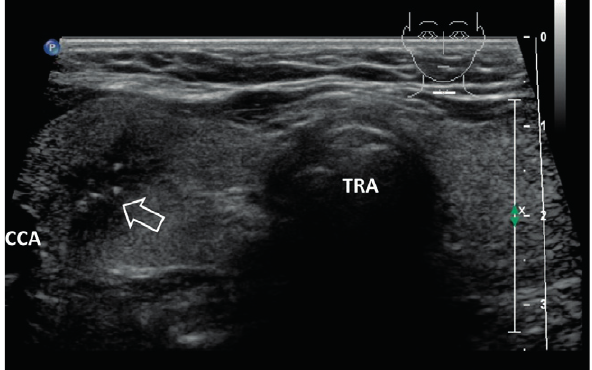
Fig. 2b. Twelve months post 3× PEIT. small solid nodule (empty arrow), size 14 × 11 × 7 mm and volume 0.6 mL as residue of cyst: inhomogeneous structure, mostly hypoechoic, tiny punctuations of fibrosis, no recurrence of the liquid component;